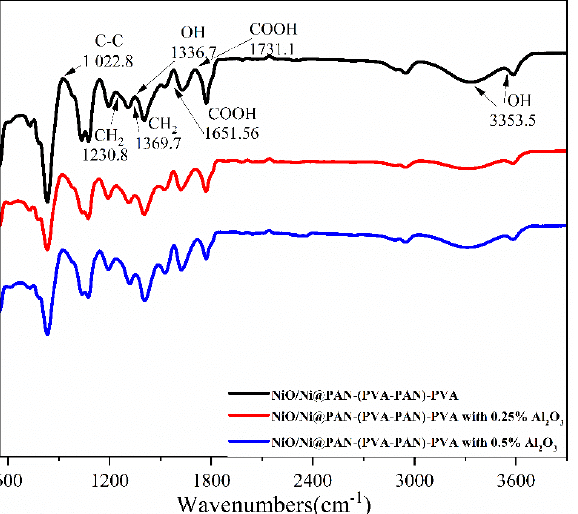
Figure 5. FTIR spectra for NiO/Ni coated with PAN-(PVA-PAN)-PVA layers and Al 2 O 3 nanofillers. Furthermore, CV measurements were conducted at a scanning rate of 0.1 mV s − 1 within a potential window between 0.01 and 3.0 V to investigate the electrochemical activity of the produced electrodes. CV profiles of NiO/Ni foam and NiO/Ni@PAN-(PAN-PVA)-PVA electrodes with and without Al 2 O 3 are shown in Figure 6a–d. CV for NiO/Ni foam electrodes shows that there is just one redox couple peak related to the oxidation of Ni 2+ [51]. The electrodes exhibit anodic and cathodic peaks at 2.18–2.29 V and 0.09–0.25 V, respectively. The formation of amorphous Li 2 O, the formation of a partially reversible solid electrolyte interphase (SEI) film, and the reduction of NiO to Ni are responsible for the first cycle’s prominent cathodic peak at about 0.09–0.25 V [52]. The cathodic peak became broader in the subsequent cycles and shifted to about 1.2 V for all electrodes. The performance of NiO electrodes as reported in the literature [53] is in agreement with the anodic peaks, which have essentially not changed. It is important to note that the addition of 0.25 and 0.5% Al 2 O 3 did not significantly change the peak potentials of any electrodes, but did cause the peak intensities of NiO/Ni@PAN-(PAN-PVA)-PVA and NiO/Ni@PAN-(PAN-PVA)-PVA to slightly rise. The peak intensities for NiO/Ni@PAN-(PAN-PVA)-PVA and NiO/Ni@PAN-(PAN-PVA)-PVA with the addition of 0.25 and 0.5% Al 2 O 3 increased very marginally; however, it is important to note that the peak potentials of all electrodes remained similar. The most stable sample is defined as NiO/Ni@PAN-(PAN-PVA)-PVA with the addition of 0.5 wt% Al 2 O 3 . The overall lithiation and delithiation can be represented in Equations (1) and (2).